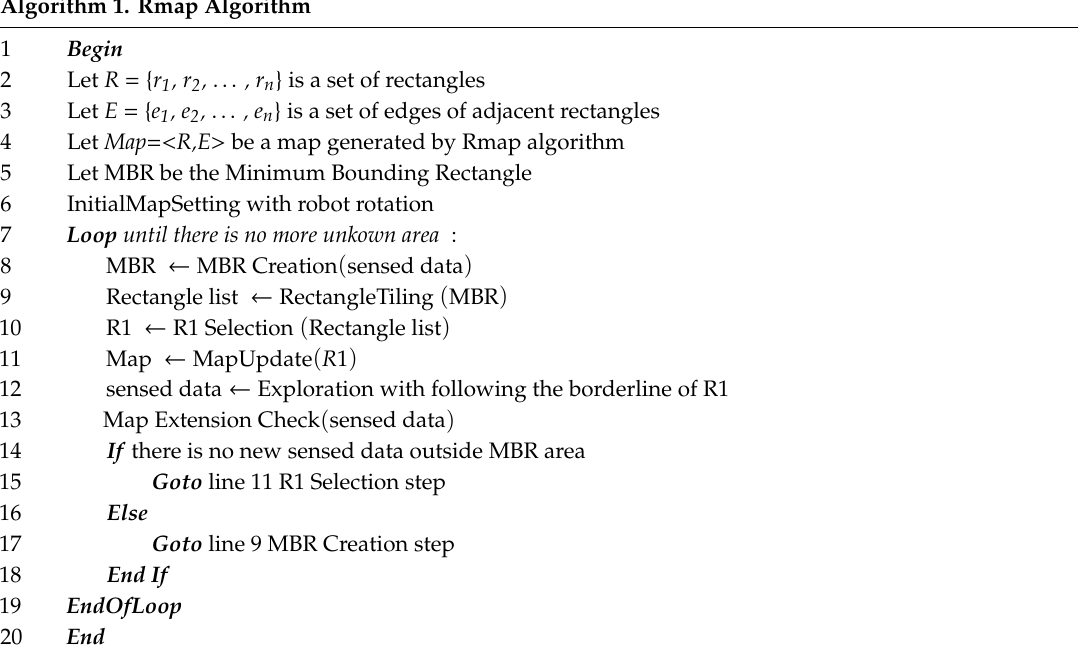
Algorithm 1. Rmap